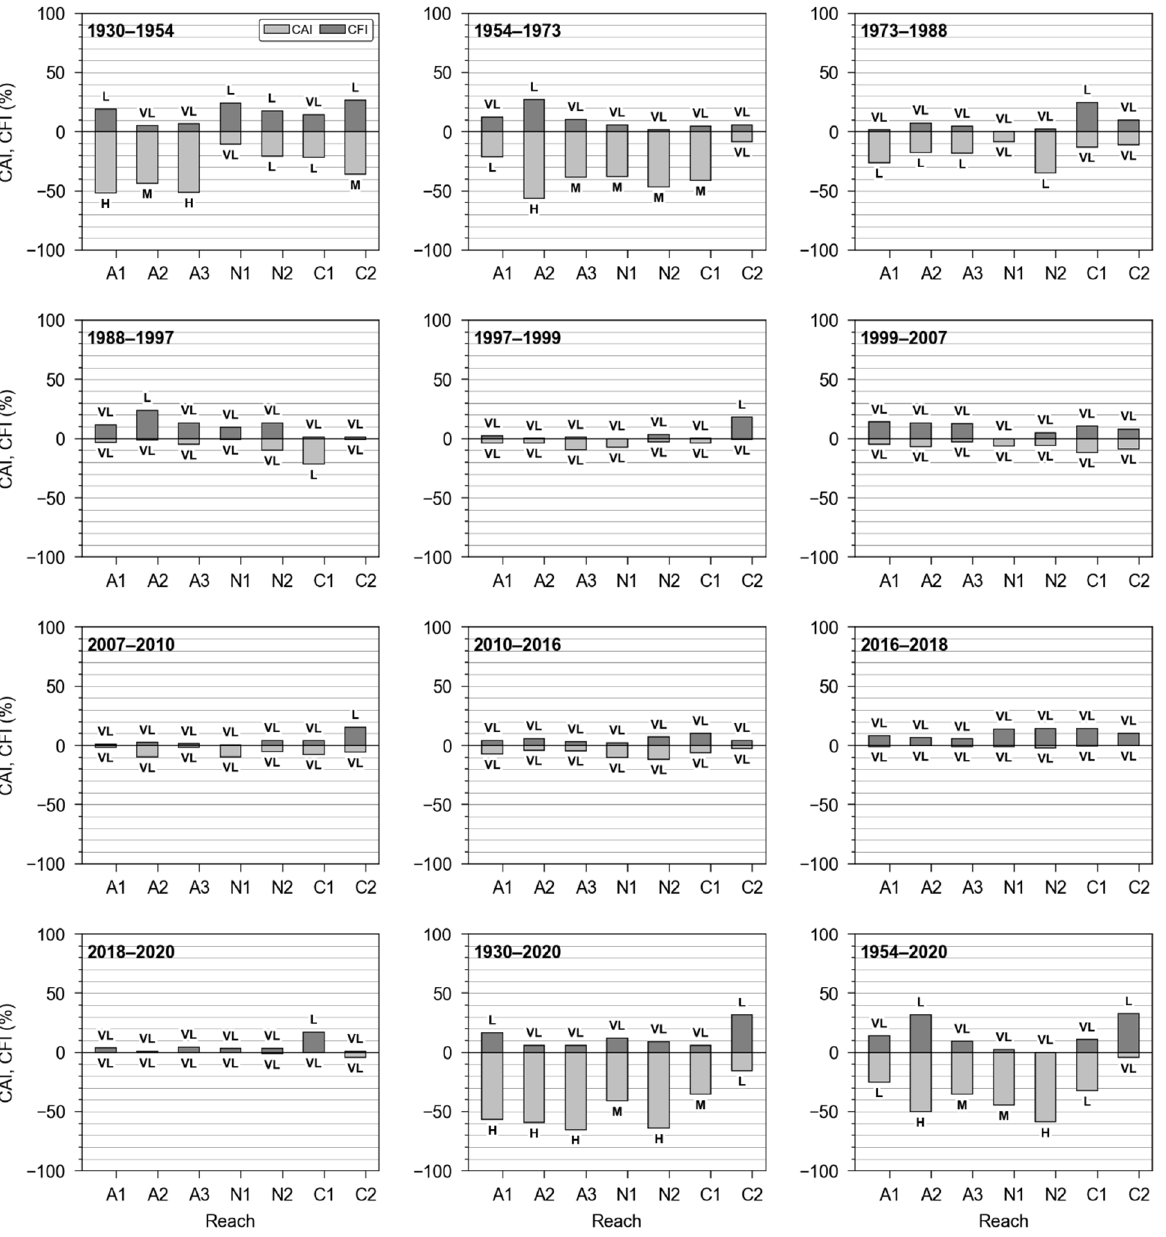
Figure 7. The channel abandonment index (CAI) and channel formation index (CFI) referred to each investigated period and to the periods 1930–2020 and 1954–2020. Letters on bars indicate the qualitative class for metrics: VL: very low ( ≤ 15%); L: low (>15% and ≤ 35%); M: moderate (>35% and ≤ 50%); H: high (>50% and ≤ 75%); VH: very high